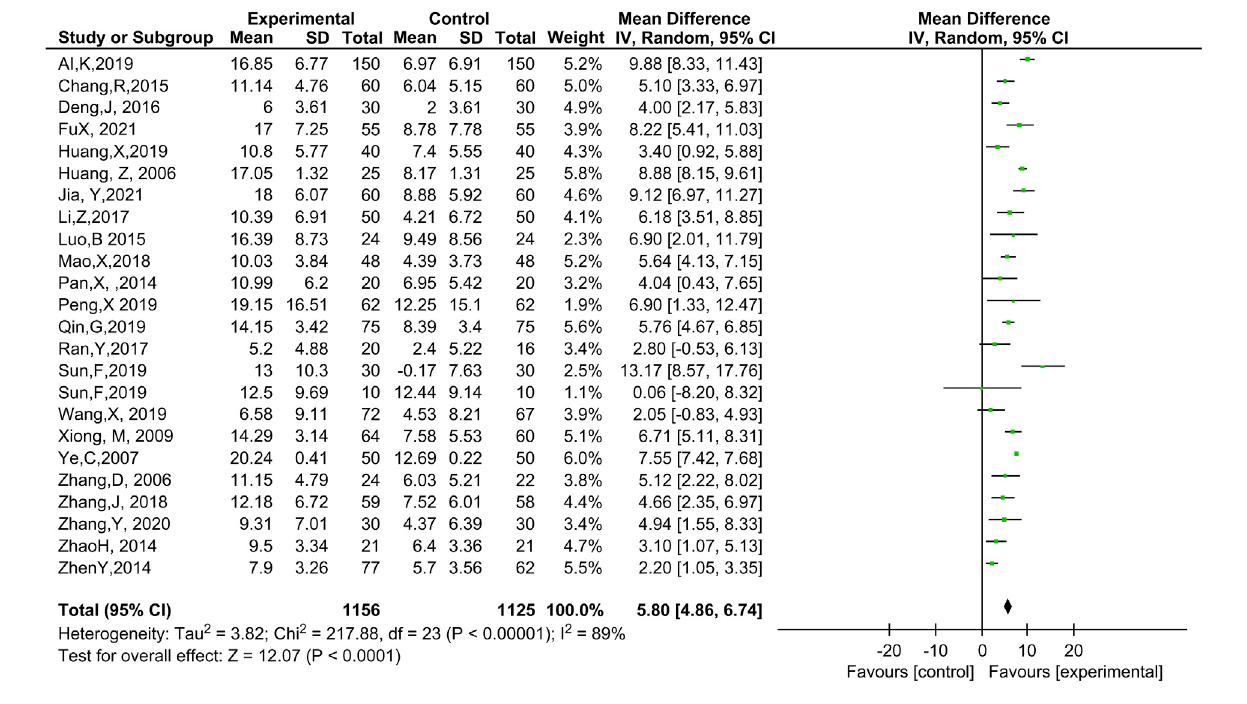
FIGURE 4 Meta-analysis results of LVEF between the experimental and control groupsL VEF, left ventricular ejection